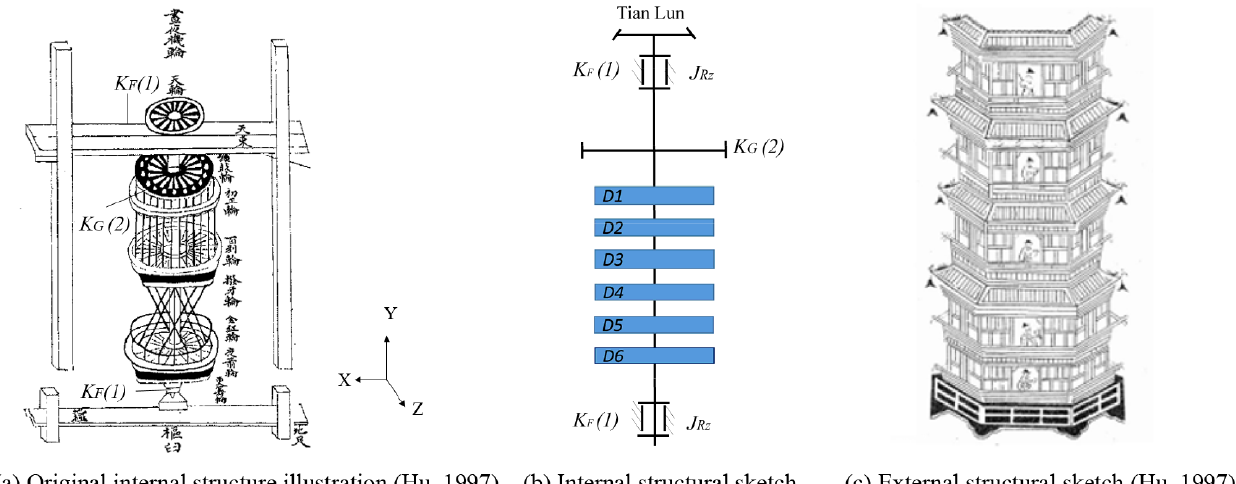
Figure 18. Time-telling wooden pagoda of the Xin yi xiang fa yao ( New design for an armillary sphere and celestial globe